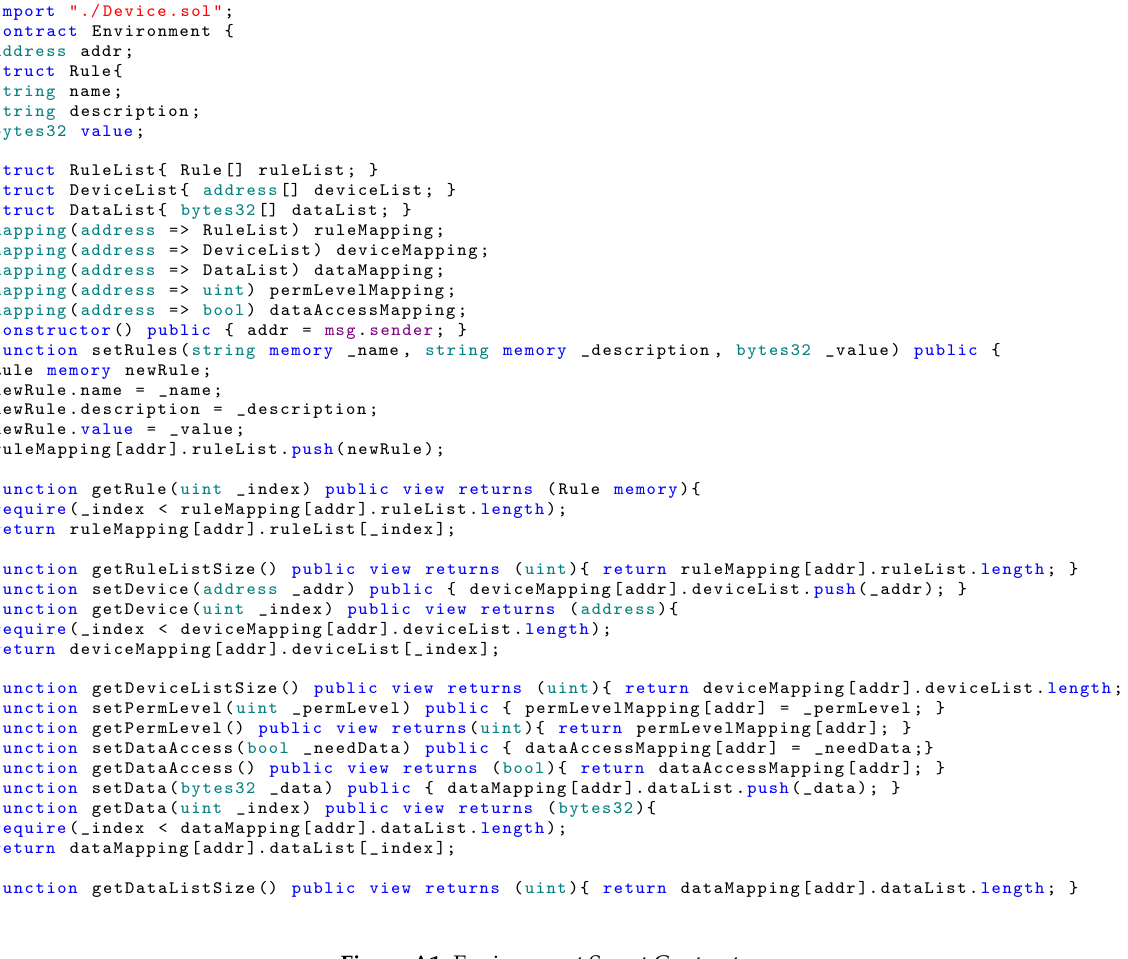
Figure A1. Environment Smart